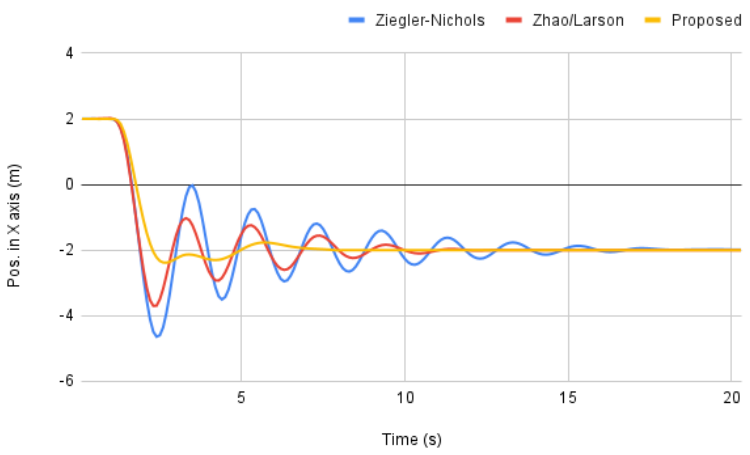
Figure 7. The comparison among Cascaded-PID tuning methods.